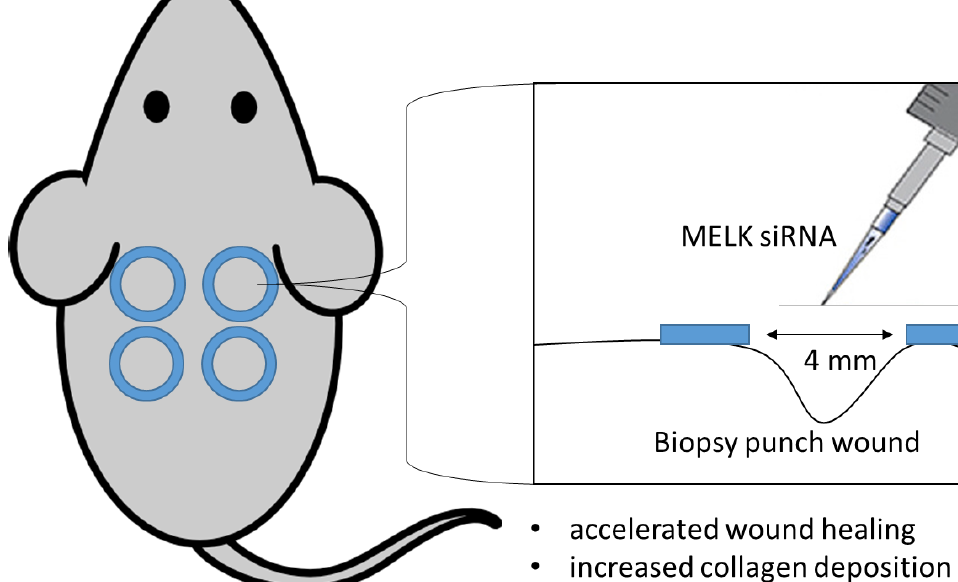
Figure 1. A simplified summarizing graphic illustration of MELK knockdown using MELK siRNA in murine wound healing model.